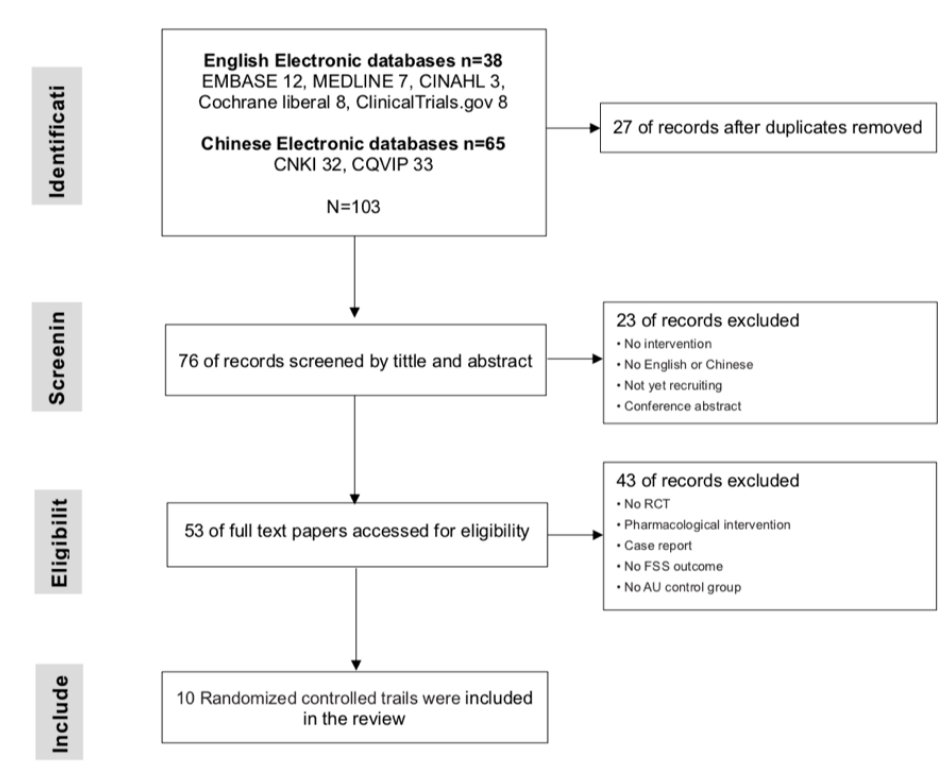
Figure 1. Flow diagram. FSS = Fatigue Severity Scale; RCT = randomized controlled trails; AU = as usual (treatment, nursing, rehabilitation, education).